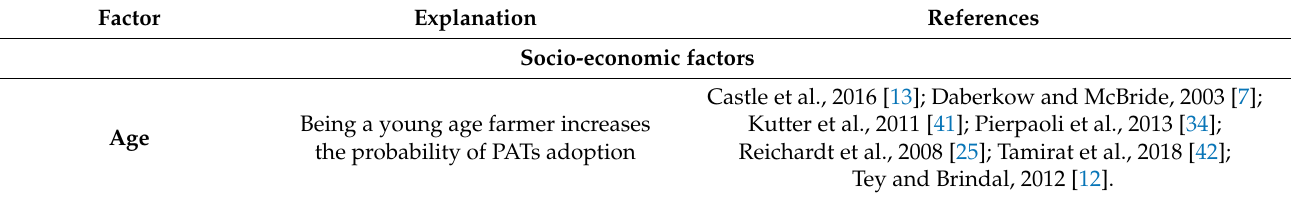
Table 1. PA adoption